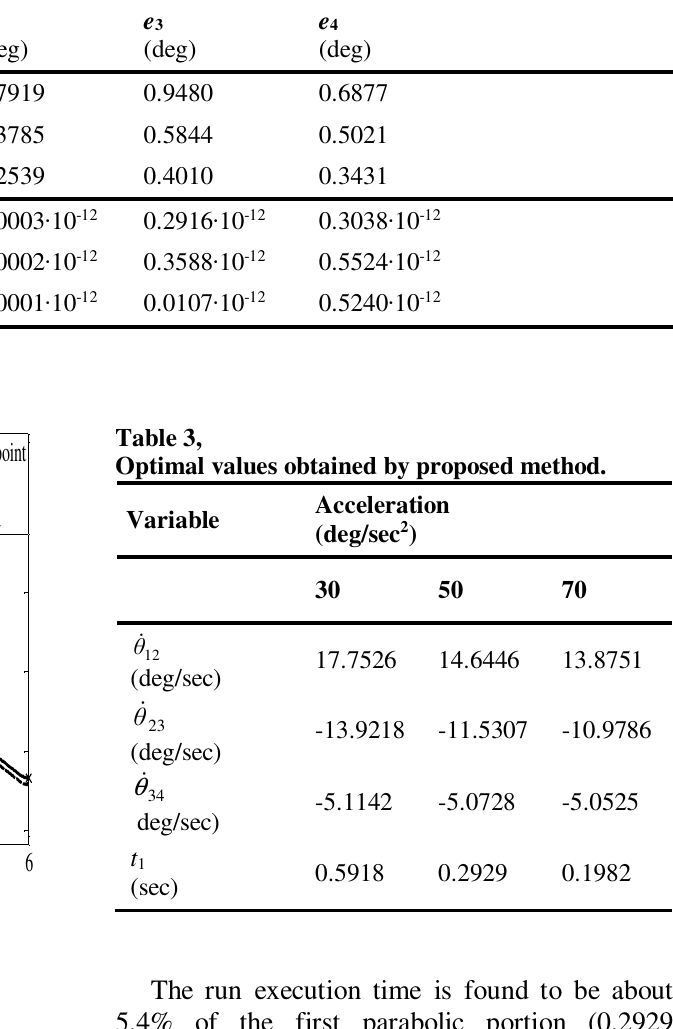
Comparison of error at through points between normal and modified LSPB using PSO.